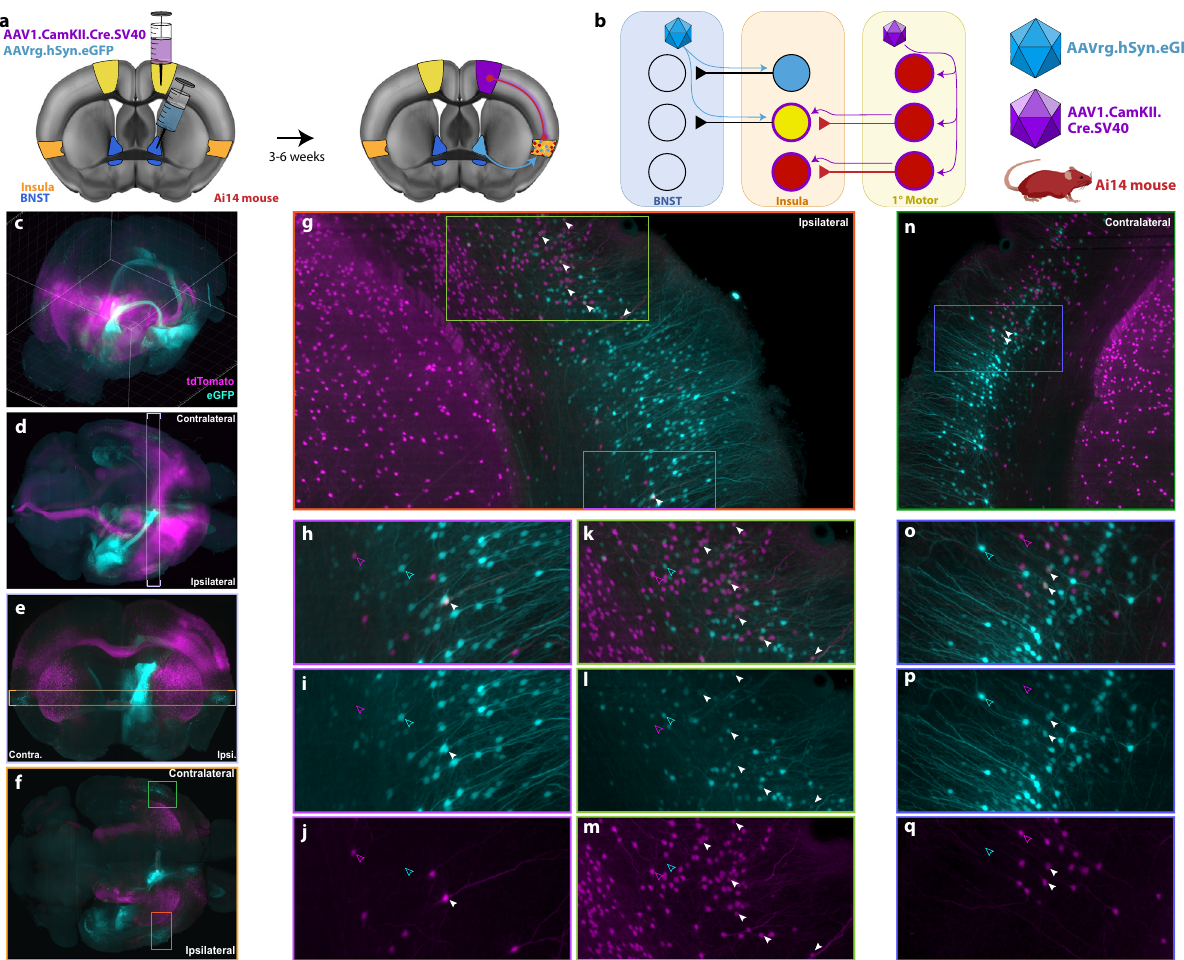
Fig. 7 Motor efferents project onto insula → BNST cells. a Diagram of AAVrg.eGFP (cyan) injected into the BNST (blue) and AAV1.Cre (purple) injected into motor cortex (yellow) of Ai14 mice. b Schematic of the viral strategy. AAVrg.eGFP retrogradely labeled insula → BNST cells. AAV1.Cre labeled neurons that are downstream from the motor cortex. Neurons that were downstream from motor cortex and projected to the BNST were doubly labeled (yellow). c Maximum projection image for 3D reconstruction of whole-brain labeling; eGFP shown in cyan and tdTomato shown in magenta. Olfactory bulbs are in the bottom left corner, and the cerebellum is in the top right corner. d Top-down view of whole brain. Light purple outline indicates the slice taken for the next image. Olfactory bulbs are to the right. Cerebellum is to the left. e Coronal slice taken at the level of the BNST. Yellow line indicates the transverse slice taken for the following image. f Maximum intensity projection of a transverse slice taken at the level of the insula. Dark green and orange boxes indicate regions of the insula that project to the BNST. They are expanded later in the fi gure. g Magni fi cation of orange box from f . Image is ipsilateral to the injection site. Light green and purple boxes are expanded and split by channel in later images. White arrowheads indicate doubly labeled neurons. h Magni fi ed image of purple box from g . Solid white arrowheads indicate doubly labeled neurons. Cyan open arrowheads indicate eGFP-only labeling. Magenta open arrowheads indicate tdTomato-only labeling. i eGFP-only channel from h . tdTomato signal does not bleed through (see open magenta arrowhead). j tdTomato-only channel from h . eGFP signal does not bleed through (see open cyan arrowhead). k Magni fi ed image of light green box from g . l eGFP-only channel from k . m tdTomato-only channel from k . n Magni fi cation of dark green box from f . Image is contralateral to the injection site. Blue box is expanded and split by channel in later images. o Magni fi ed image of blue box from n . p eGFP-only channel from o . q tdTomato-only channel from o